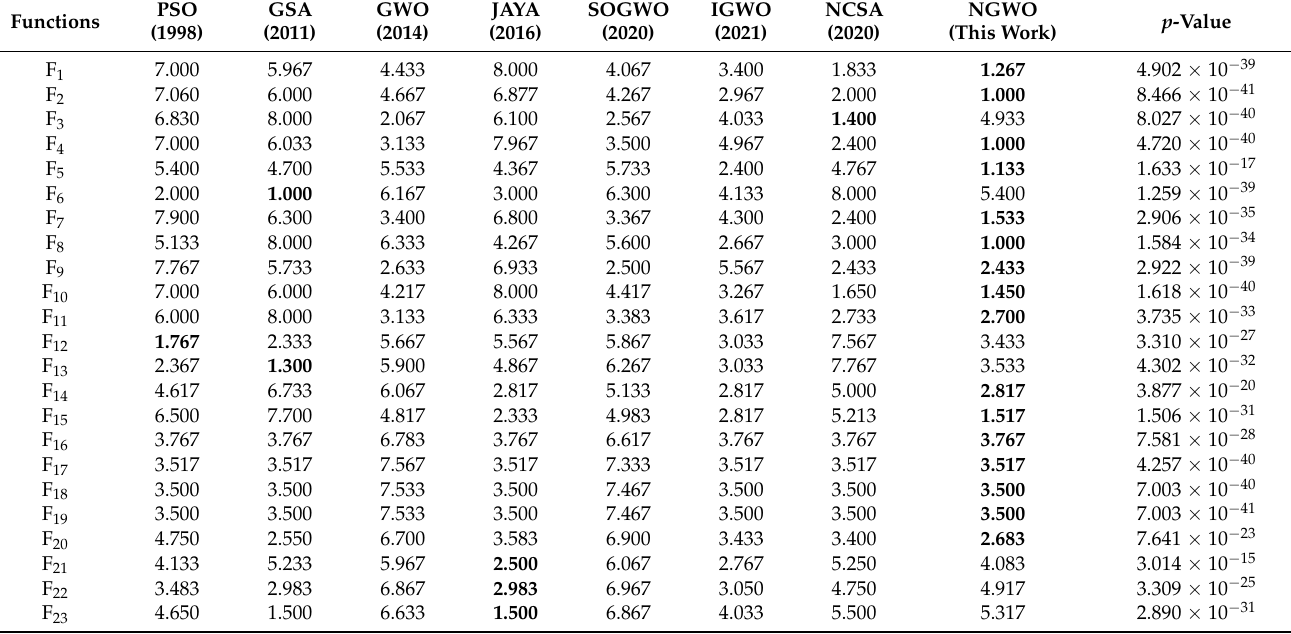
Table 5. Ranking of the algorithms based on the Friedman